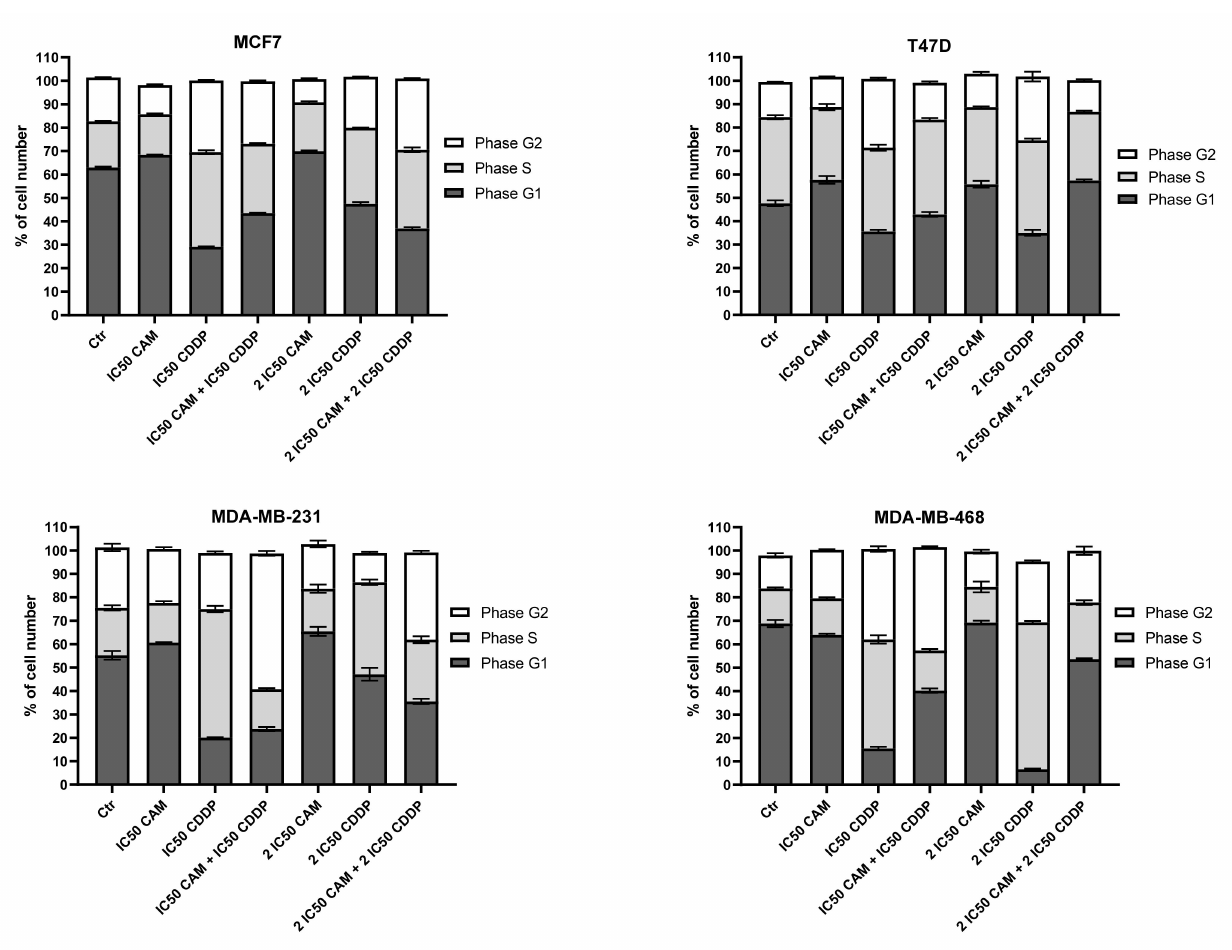
Figure 6. The effect of CAM and CDDP administered separately and in combination used in concentration of IC 50 and 2IC 50 for ( A ) MCF7, ( B ) T47D, ( C ) MDA-M23, and ( D ) MDA-MB-468 cell lines on cell cycle progression. The results are presented as mean ± SD from three independent